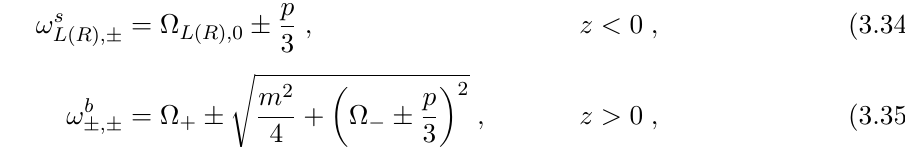
Figure 3 . The dispersion curves for an E lepton in the symmetric phase ω s ω s , ω s (red solid) and in the broken phase ω b L + L − of ω are given in (3.34) and (3.35). We here take g R = 0 . 6 , y E = 0 . 015 and v R ( T R ) /T R = 3